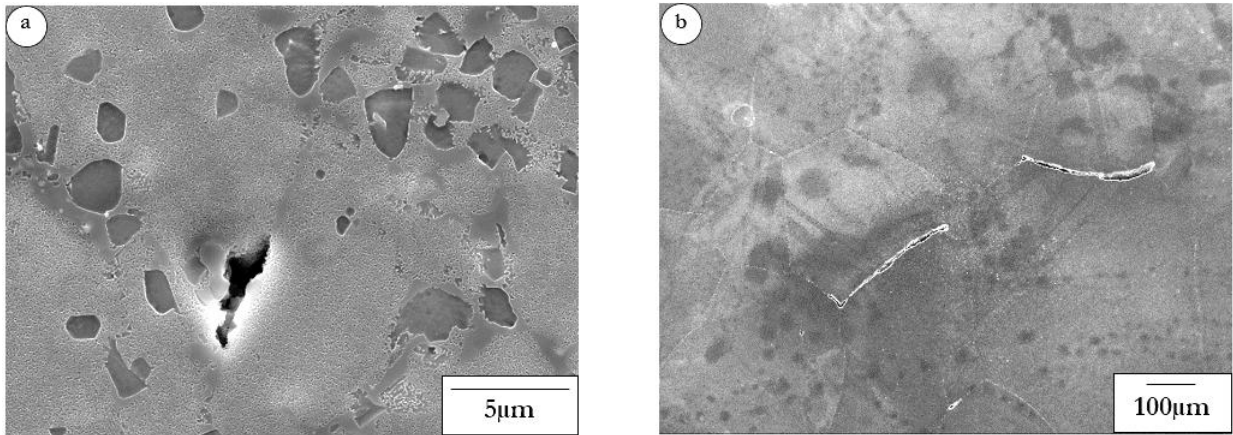
Figure 8. Post-Mortem longitudinal observations: ( a ) Fine grains microstructure, 850 °C/250 MPa; ( b ) Coarse grains microstructure, 850 °C/250